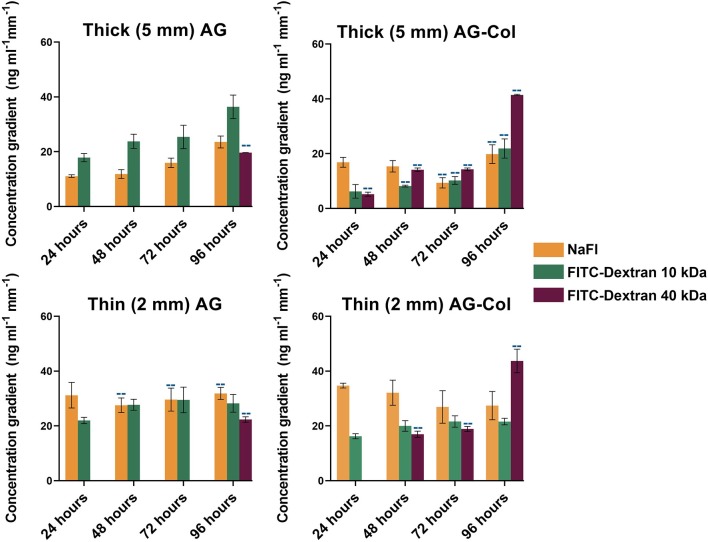
Steepness of the concentration gradient (ng mL−1 mm−1) as determined between the linear 2,500–7,500 μm region of the hydrogel chamber where cells will be cultured. Each data point represents the mean (number of replicate devices: n = 3; where indicated by “--” n = 2) ± SD.